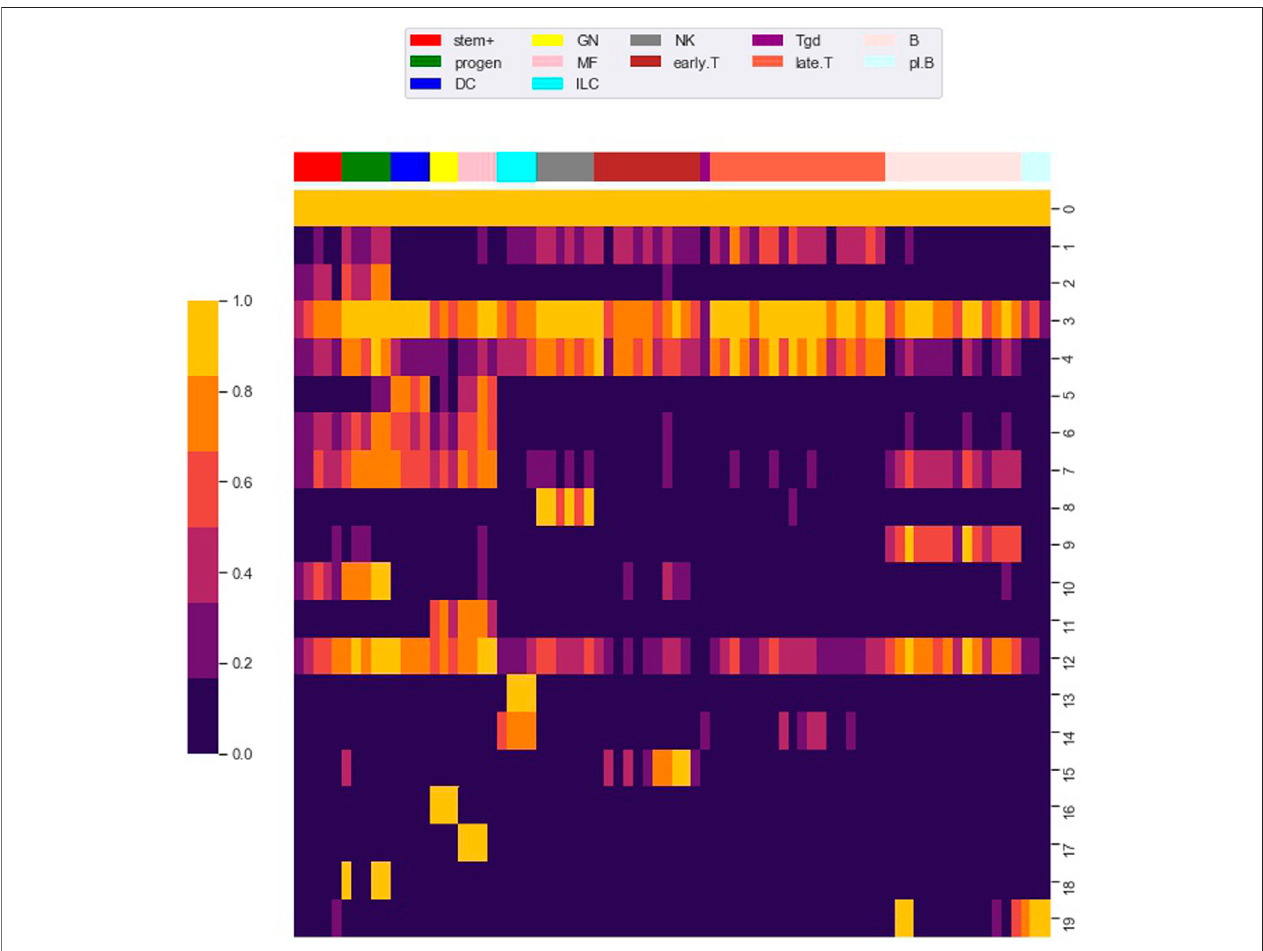
FIGURE 4 | Row clustering using the louvain algorithm. We used the Louvain algorithm to cluster 98,848 rows (i.e. loci) of the M matrix, giving 20 main row (i.e. locus)clusters.Eachrowintheheatmapcorrespondstoarowclusterandeachcolumntoacelltype.Thenumberoflociineachrowclusterisgivenin Table2 .Heatmap colorsshow thefraction ofloci withinarow clusterthat wereaccessiblefor theparticular celltype. Column groupings bycell type are based onour column clustering for k (cid:1) 12 discussed below.